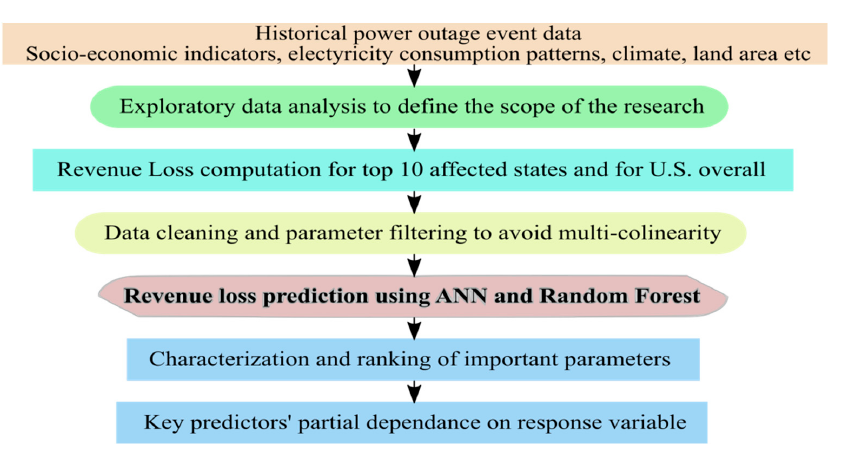
Figure 15. The flow chart of the revenue loss prediction due to major power outages.